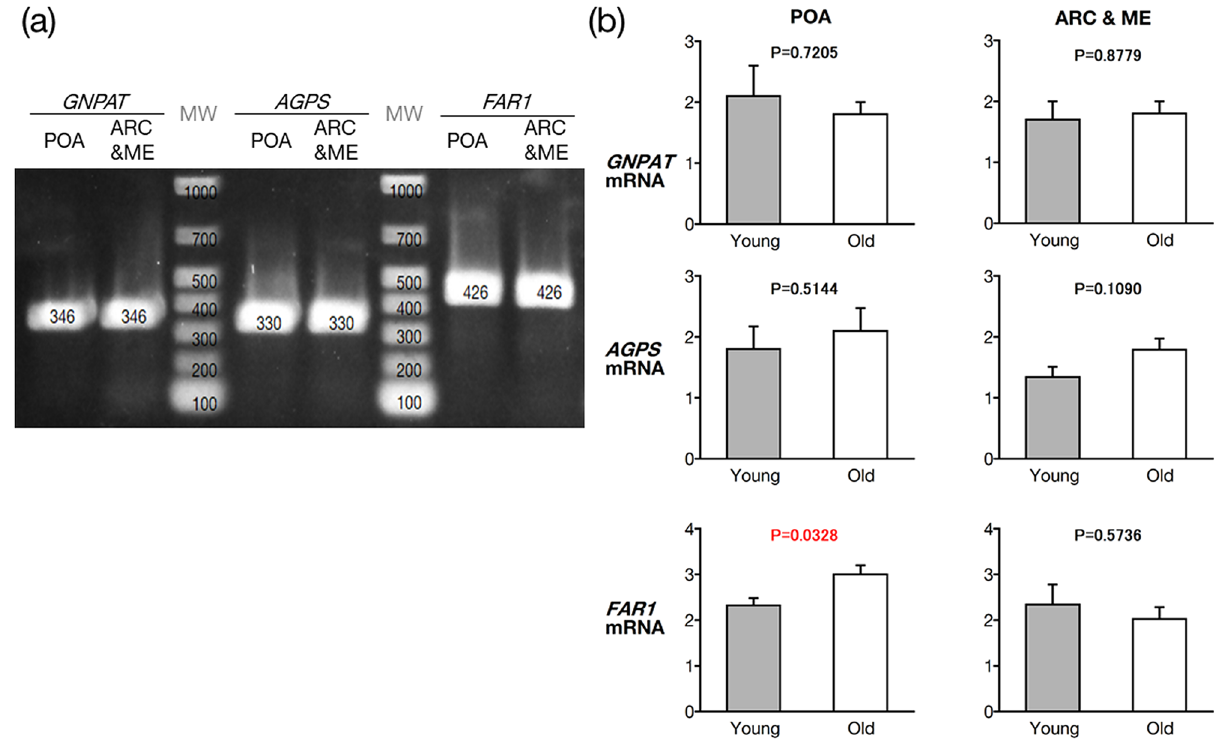
Figure 3. Electrophoresis of amplified DNA produced using RT-PCR to detect expressed mRNA of all three EPl biosynthesis enzymes (i.e. GNPAT, AGPS, and FAR1) ( a ) and compared using quantitative RT-PCRs ( b ). We used primers for each enzyme and cDNA derived from the POA and ARC&ME tissues in fertile, young heifers (26 months old), or old cows (90 months old). ( a ) All lanes were obtained from the same gel; the lanes labelled as enzyme name demonstrate that the obtained DNA products had the expected size (346, 330, and 426 bp, respectively), whereas the other two lanes (MW) correspond to the DNA marker. Two-tailed unpaired